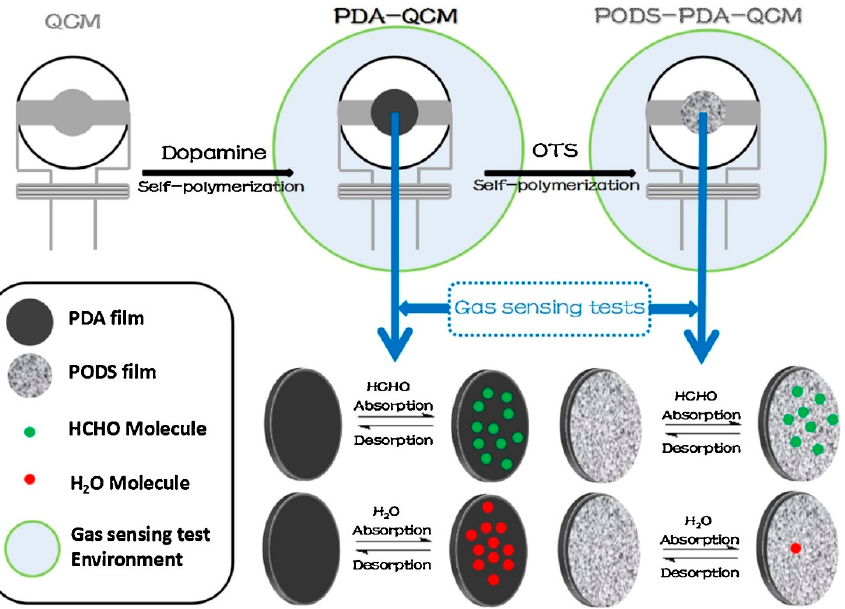
Figure 6. Structural diagram of PODS-covered PDA film-based formaldehyde sensor and the work principle of the sensor [59] . (Copyright (2018) ELSEVIER).